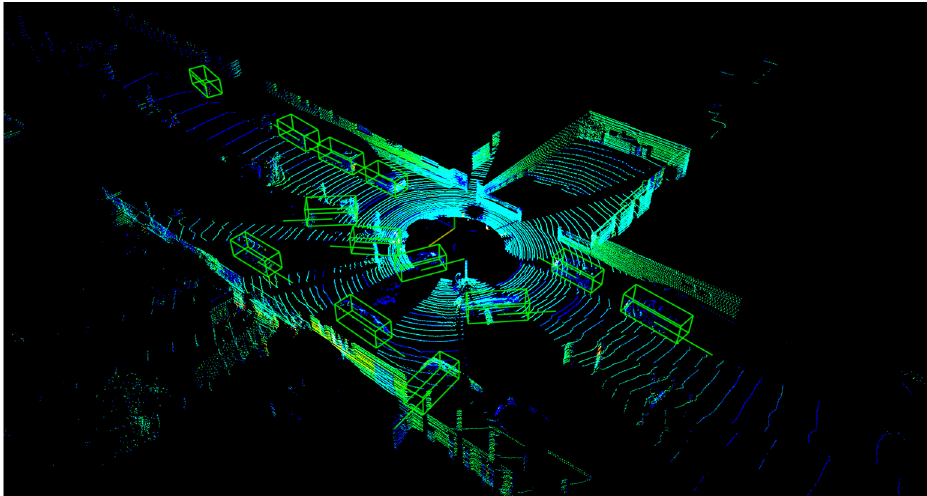
Figure 10. The final detection results by refined point cloud stitching.